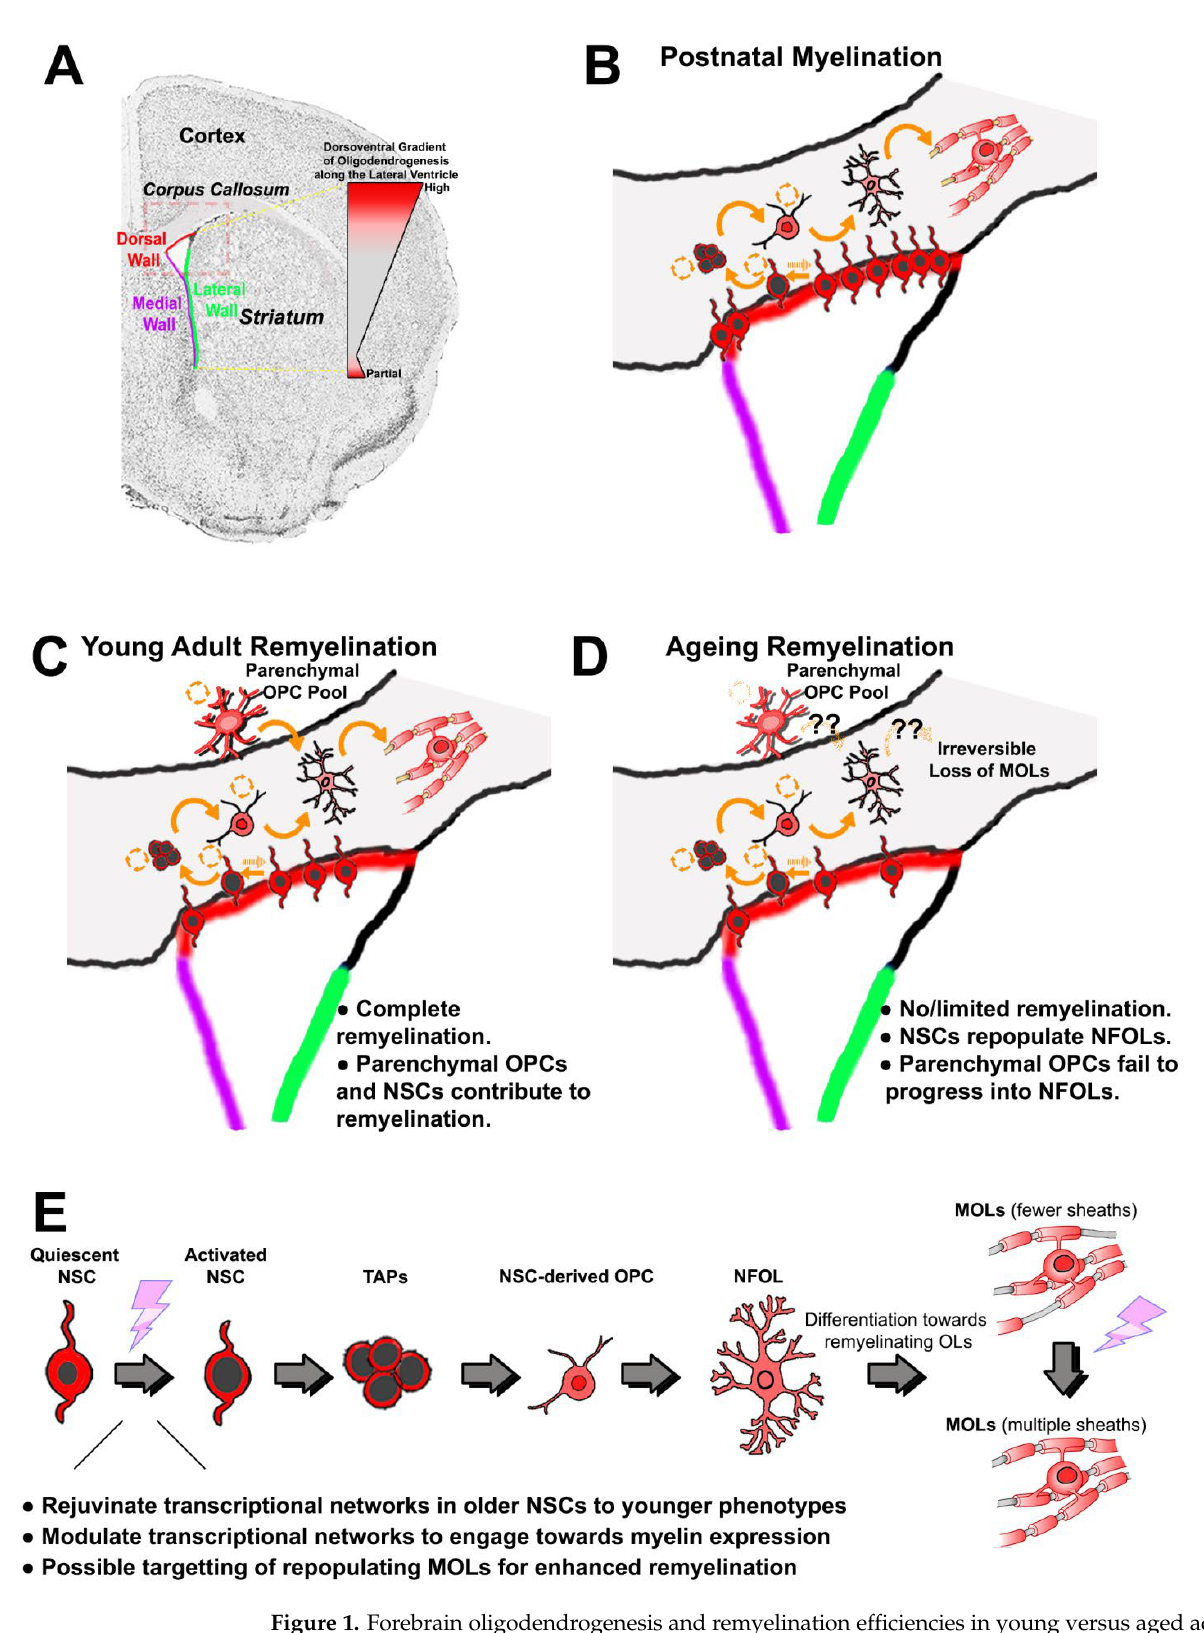
Figure 1. Forebrain oligodendrogenesis and remyelination efficiencies in young versus aged adults. ( A ) Coronal brain section counterstained for nuclei; the corpus callosum is evident as light grey, and the SVZ zones and other regions of interest are indicated. The dorsoventral gradient of oligodendrogenesis in the SVZ is illustrated; OPCs are generated primarily from NSCs in the dorsal microdomain, and at lower rates in the most ventral regions of the SVZ. This preferential